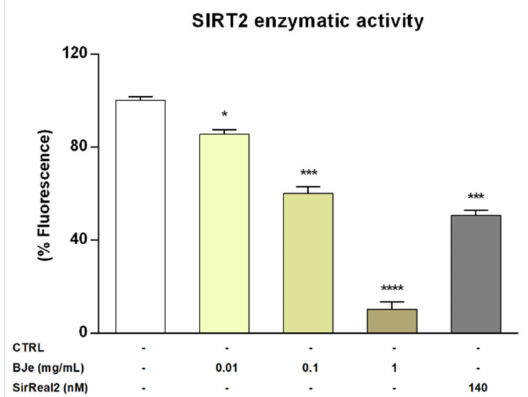
Figure 8. SIRT2 activity in a cell-free model. Control (CTRL, white bar) consists in the isolated recombinant enzyme, while BJe (yellow bars) was tested at the concentrations shown in the figure. The SIRT2 inhibitor, SirReal2, was employed as positive control (grey bar). Data are expressed as percentage of fluorescence corresponding to SIRT2 enzymatic activity ± SEM of three independent experiments performed in triplicate ( n = 9). * p < 0.05, *** p < 0.001 and **** p < 0.0001 vs. CTRL.